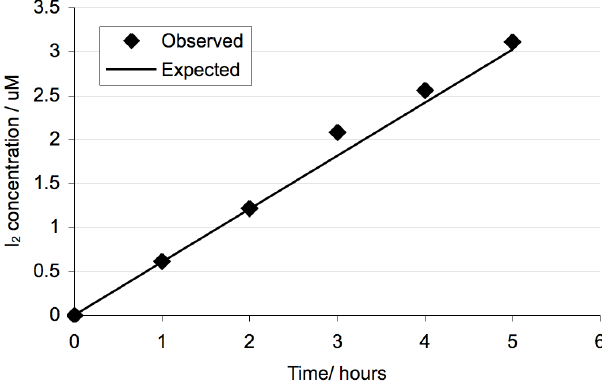
Fig. 6. Observed and expected iodine concentrations in the opti- mised hexane solvent trap at − 50 ◦